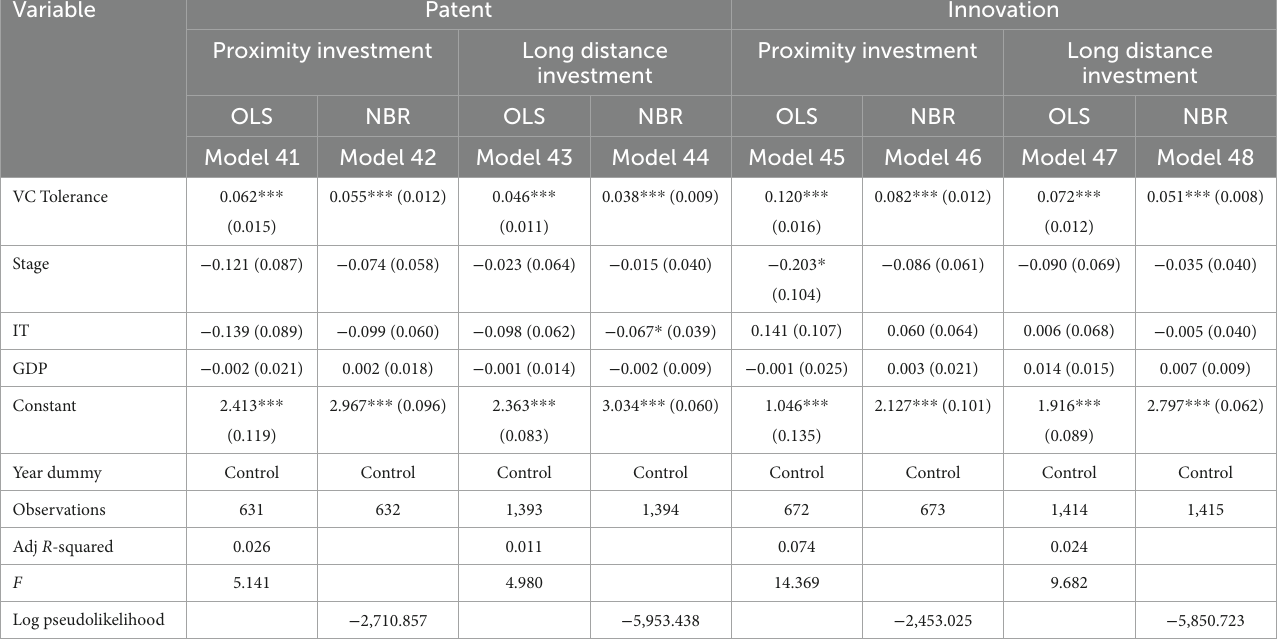
TABLE 9 Regression results of the moderating effect of geographical proximity on the relationship between VC failure tolerance and enterprise innovation